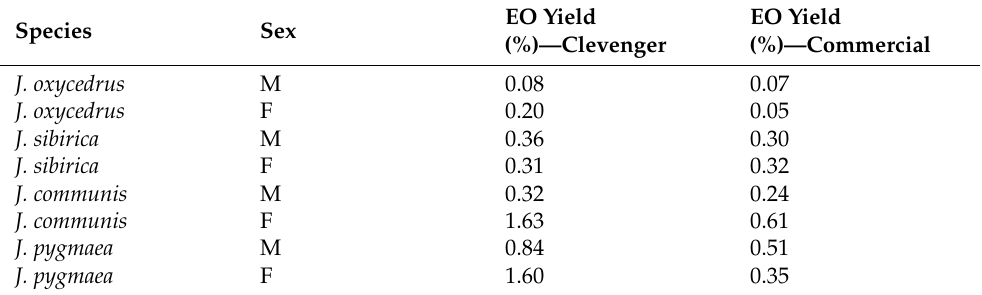
Table 1. Essential oil (EO) content of Juniperus oxycedrus , J. communis , J. pygmaea , and J. sibirica as a function of the sex of the tree and the extraction method. Species Sex